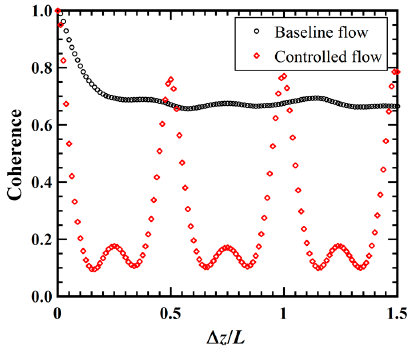
Figure 18. Spanwise coherence of streamwise velocity, u , at x / L = 0.5 and y = 0 for baseline and controlled flows.